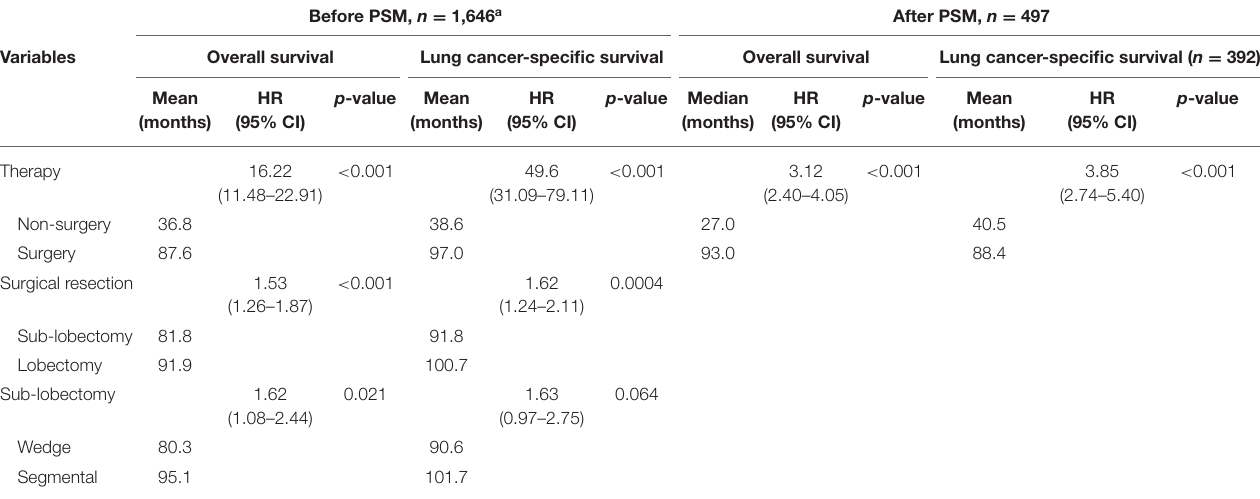
TABLE 2 | Overall survival and cancer-specific survival of different treatments in patients with tumor size ≤